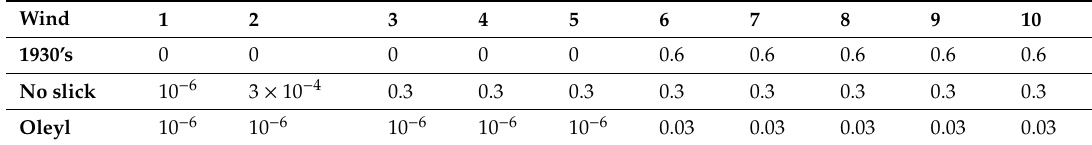
Table 1. Some roughness length measurements as a function of the wind speed. Classical pre-Second World War estimates were inserted at the top for comparison, but the focus is primarily on artificial East Coast slick experimental data, as described in the text. Surfactant dependence is stark and ranges over orders of magnitude. The more modern results are smoothed from relatively noisy anemometer data. For purposes of re-introducing the heights into Prandtl theory, we connect free (clean) values to surfactant saturated ones in a log linear manner. Speed is averaged in m / s, and z o is given in centimeters. Notice the strongest changes occur at low to average winds of a few meters per